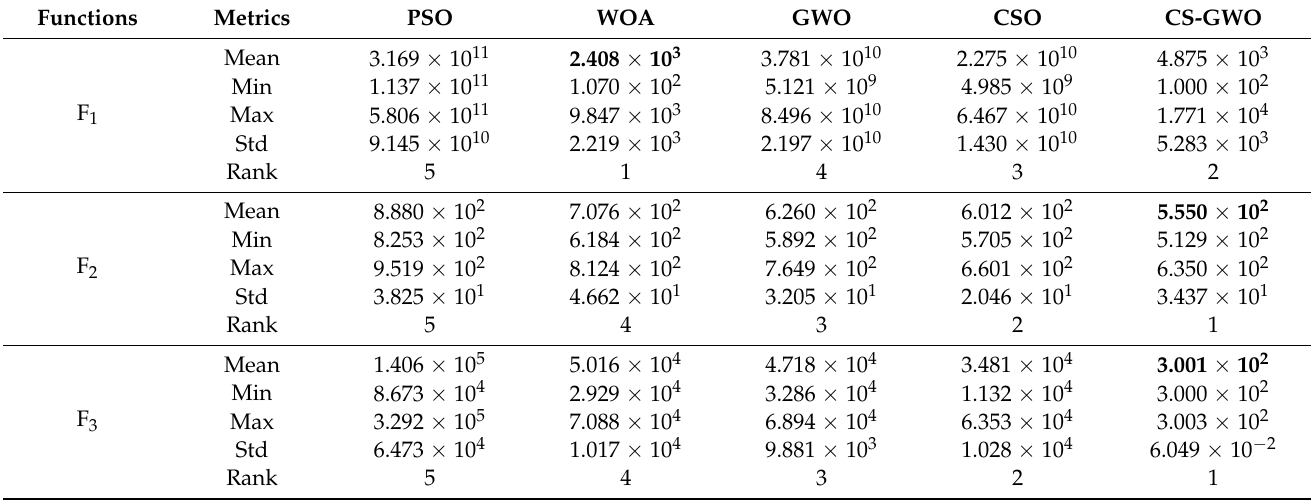
Table 2. Comparison of CS-GWO with well-known algorithms for CEC 2017 test